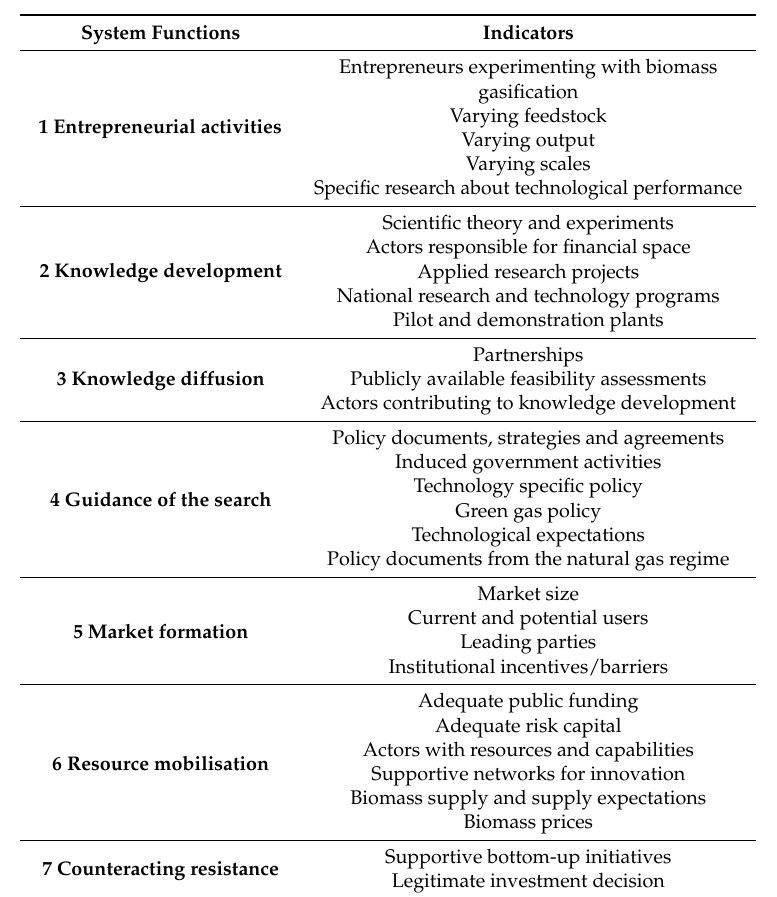
Table 1. Technological Innovation System (TIS) system functions and operationalised indicators applied in this